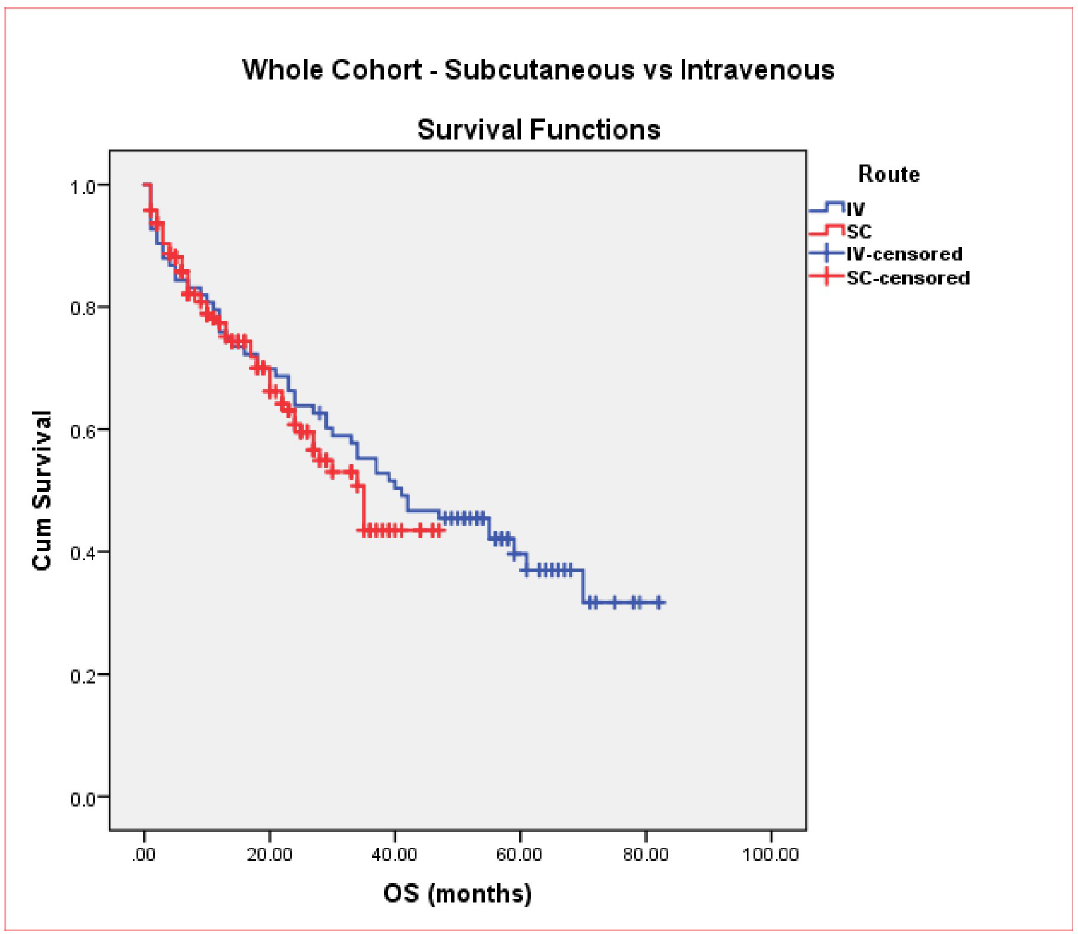
Fig 1. OS in total cohort (sc vs. iv).